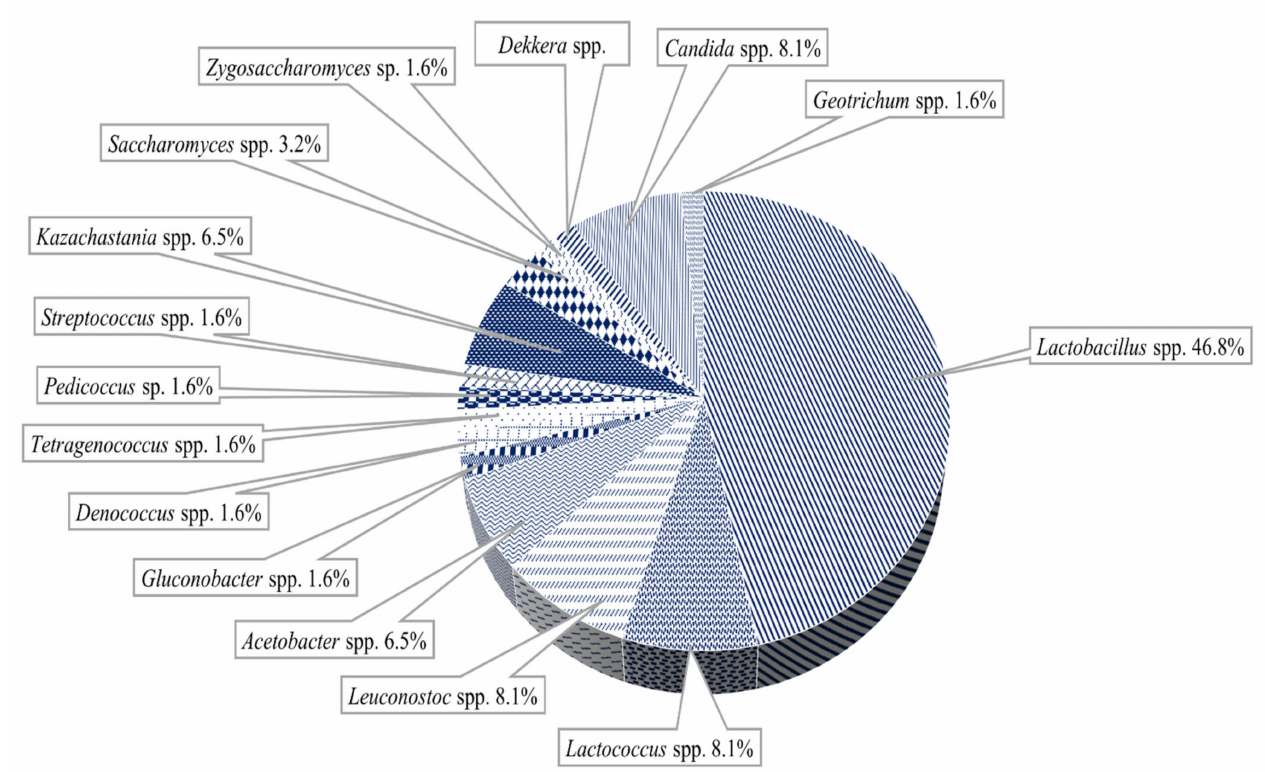
Figure 5. Predominant microorganisms in the milk kefir grains microbiota (adapted from Bengoa et al.